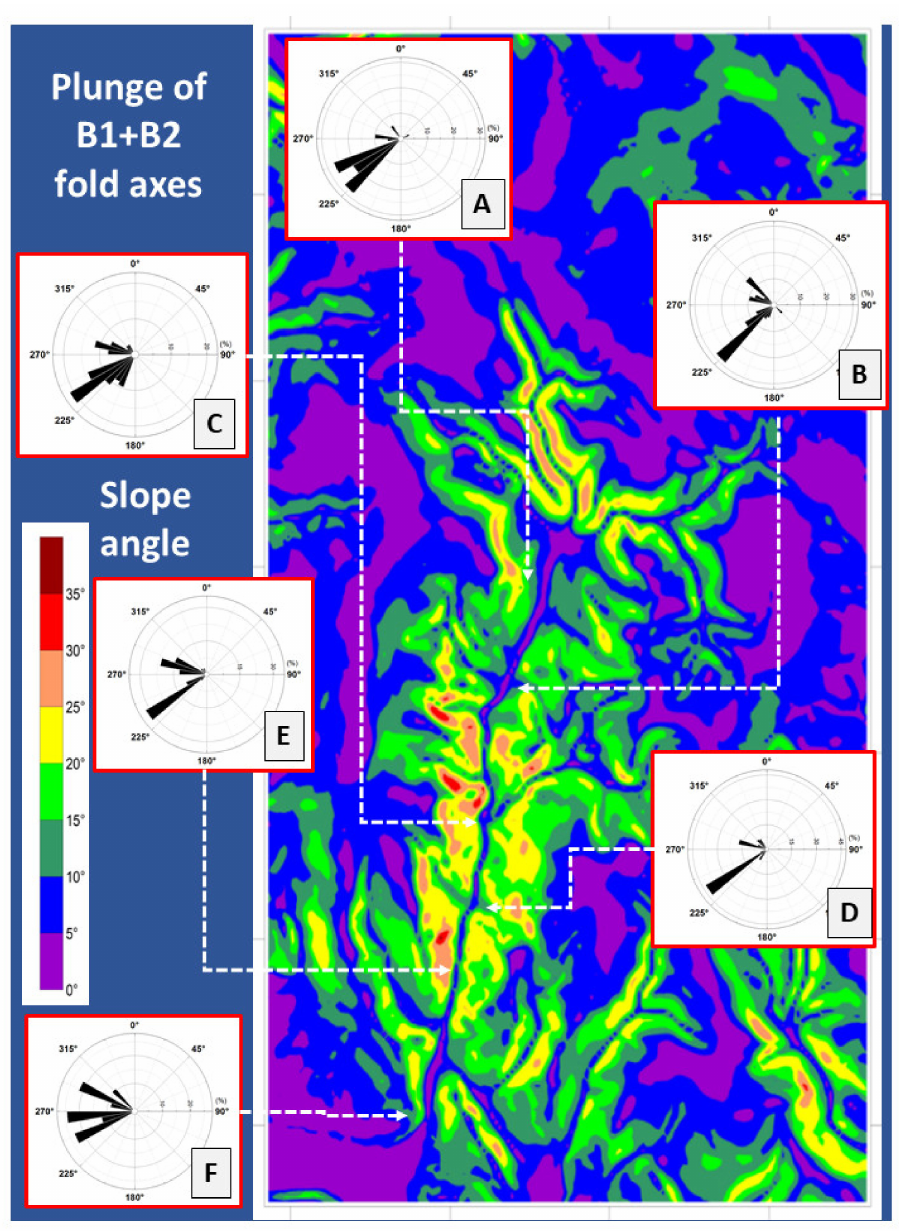
Figure 13. Slope angles (between 0 and 40 ◦ ) in the Steinach Drainage System as a function of the plunge of fold axes of minor folding phases on the NW limb of the Fichtelgebirge Anticline (see also Figure 10). ( A ) to ( F ) refer to the sections mentioned in the